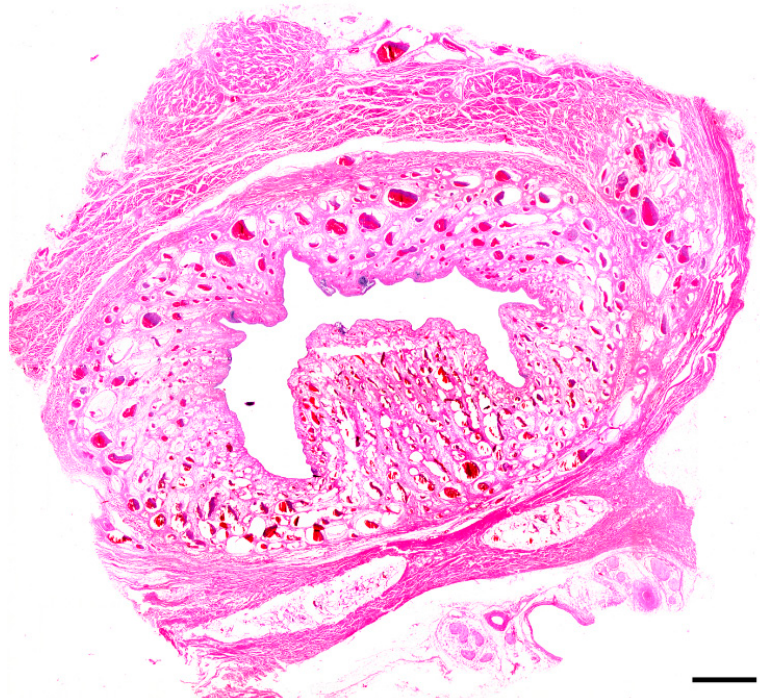
Figure 1. Cross section of entire mass (20x; hematoxylin and eosin). The mass is composed of a moderately dense fibrovascular stroma containing numerous blood-filled channels surrounding a lumen lined primarily by urothelium with multifocal aggregates of well-differentiated hair follicles and associated adnexal structures; bar = 2 mm.